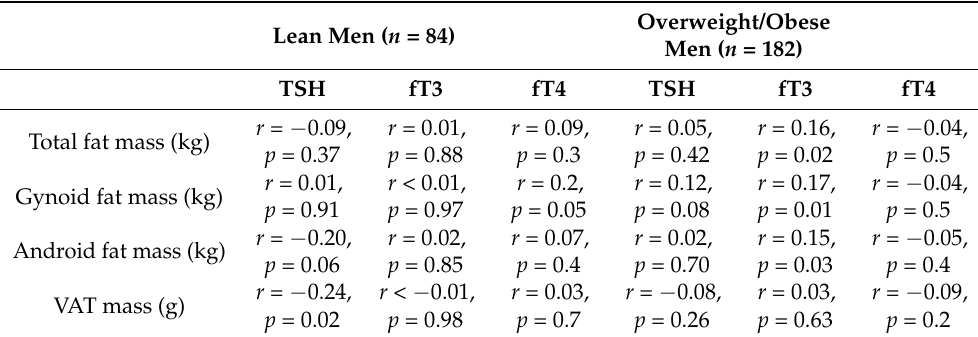
Table 4. Relationships between serum TSH and fT3 concentrations and body composition parameters estimated with DXA in lean and overweight/obese men.